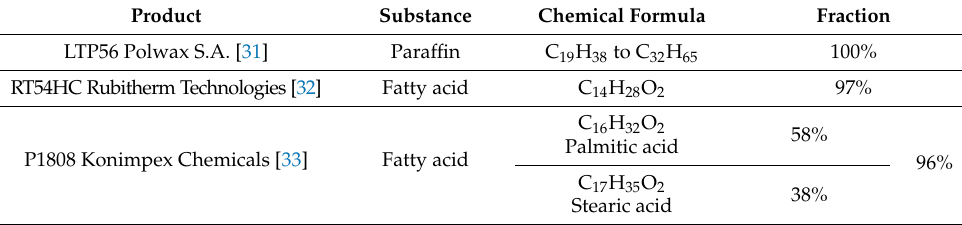
Table 2. Materials characteristics.